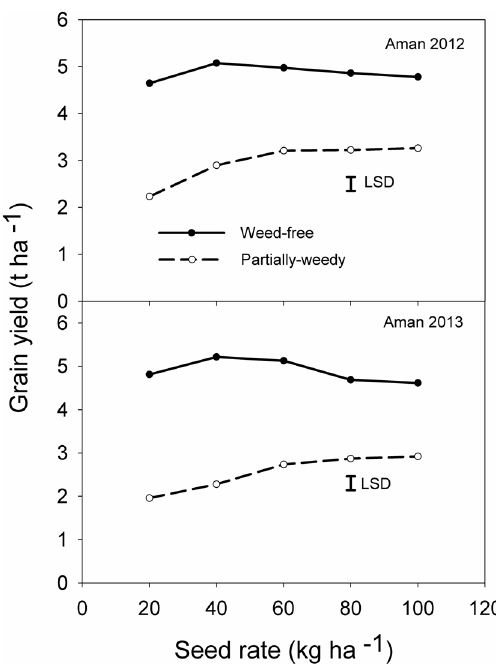
Figure 6. Effect of rice seeding rate and weed infestation level on the number of rice grains panicle 2 1 at crop harvest in 2012 and 2013.